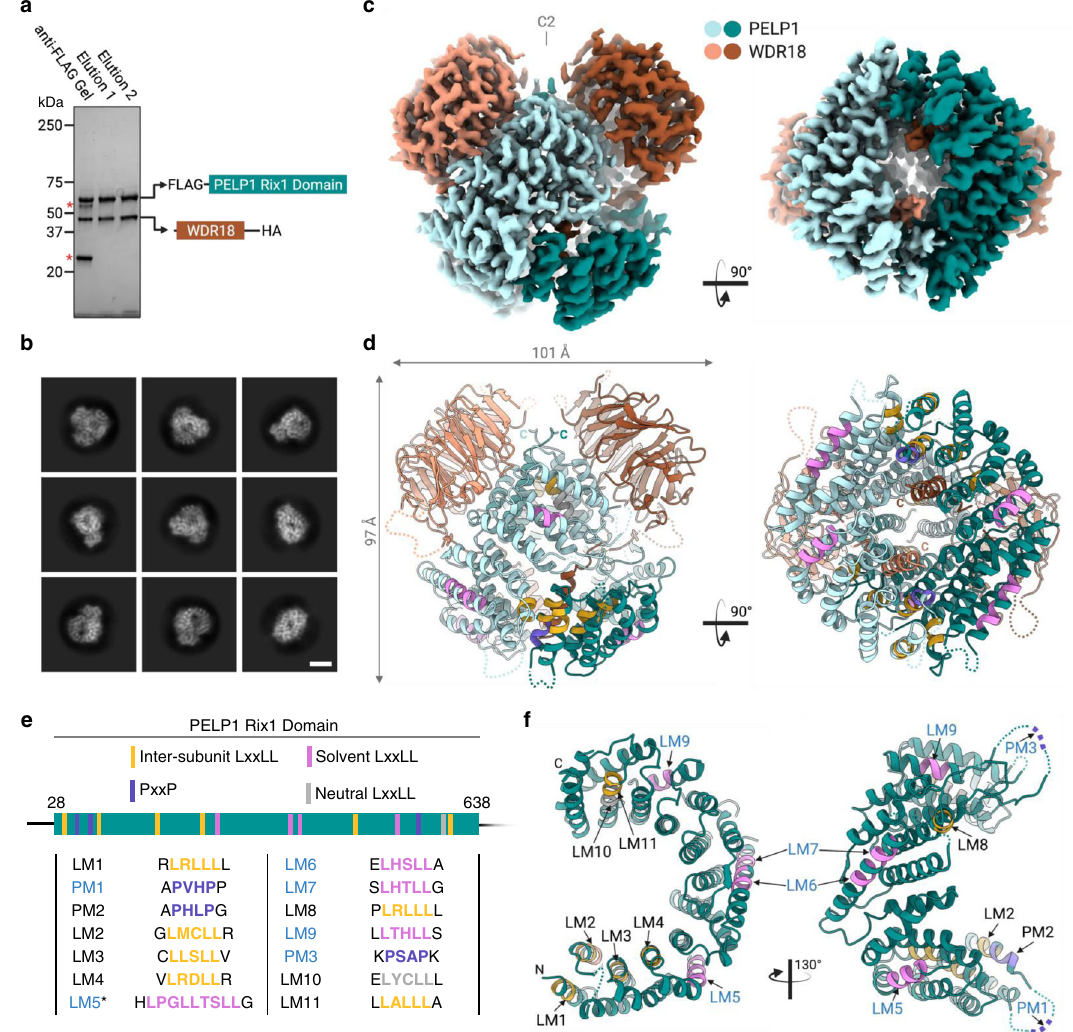
Fig. 2 | Cryo-EM structure of the human PELP1 Rix1 domain bound to WDR18. a SDS-PAGE and total protein stain of puri fi ed PELP1-WDR18 sub-complex from HEK293FTcells.RedasterisksdenoteIgGbandsfromanti-FLAGaf fi nitygel.Protein puri fi cation was performed at least three times with reproducible results. b Representative single-particle 2D classi fi cation images from cryo-EM data pro- cessing.Scalebar=50Å. c Sharpenedcryo-EMdensityofPELP1Rix1domainbound to WDR18 exhibiting a heterotetramer assembly with C2 symmetry. Side and bot- tom views are shown. d Ribbon model of same views shown in ( c ). The visualized binding motifs (LxxLL and PxxP) in PELP1 ’ s Rix1 domain are color-coded based on